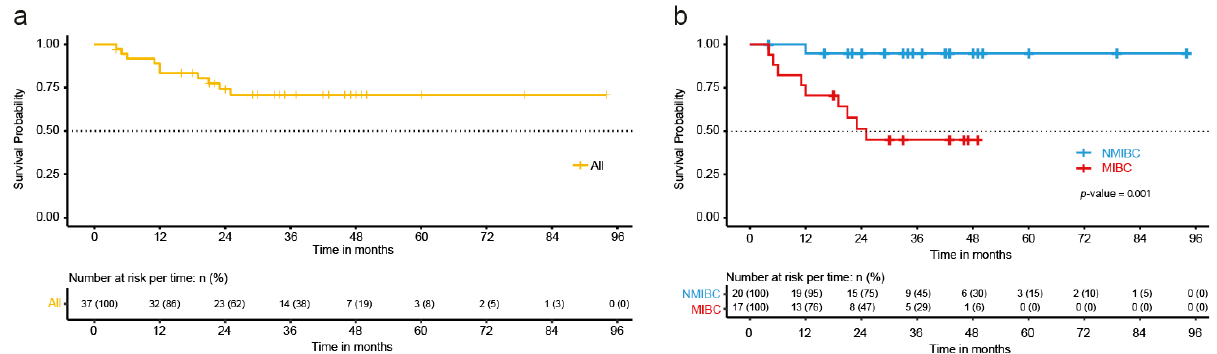
Figure 1. Overall survival of the patients with bladder cancer treated at the INCan (N = 37) between 2012 and 2021; ( a ) Kaplan-Meier curve depicting the overall survival of all the patients included in the study; ( b ) Kaplan-Meier curve showing the overall survival differences between the patients with non-muscle invasive bladder (NMIBC) cancer and muscle-invasive bladder cancer (MIBC); The p- value was calculated using the Log Rank test.